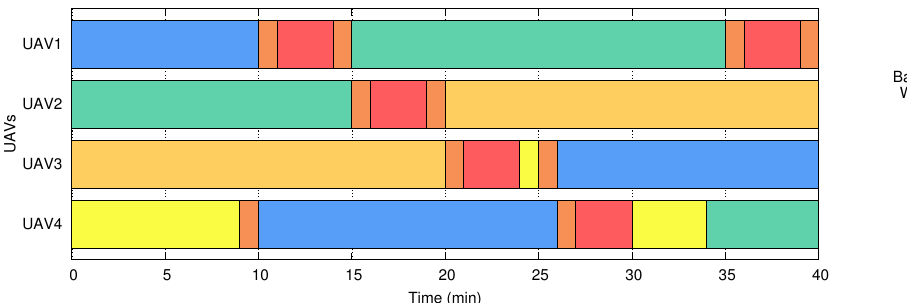
Figure 3. Multi-UAV system states during a mission for three target areas ( j = 3) and four UAVs ( i =